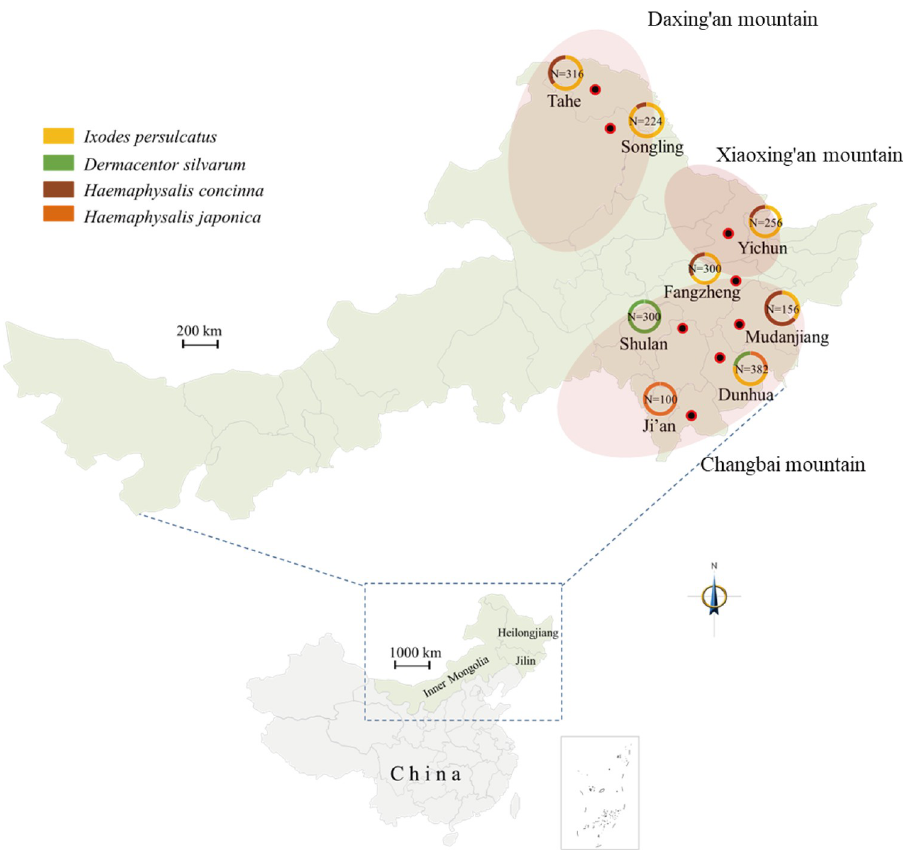
Fig 1. Sampling sites of ticks in northeastern China. The number of ticks collected at each site was marked, and species was shown by different colors. Yellow, Ixodes persulcatus ; Green, Dermacentor silvarum ; Brown, Haemaphysalis concinna ; Orange, Haemaphysalis japonica . The link to the base layer of the map is http://bzdt.ch.mnr.